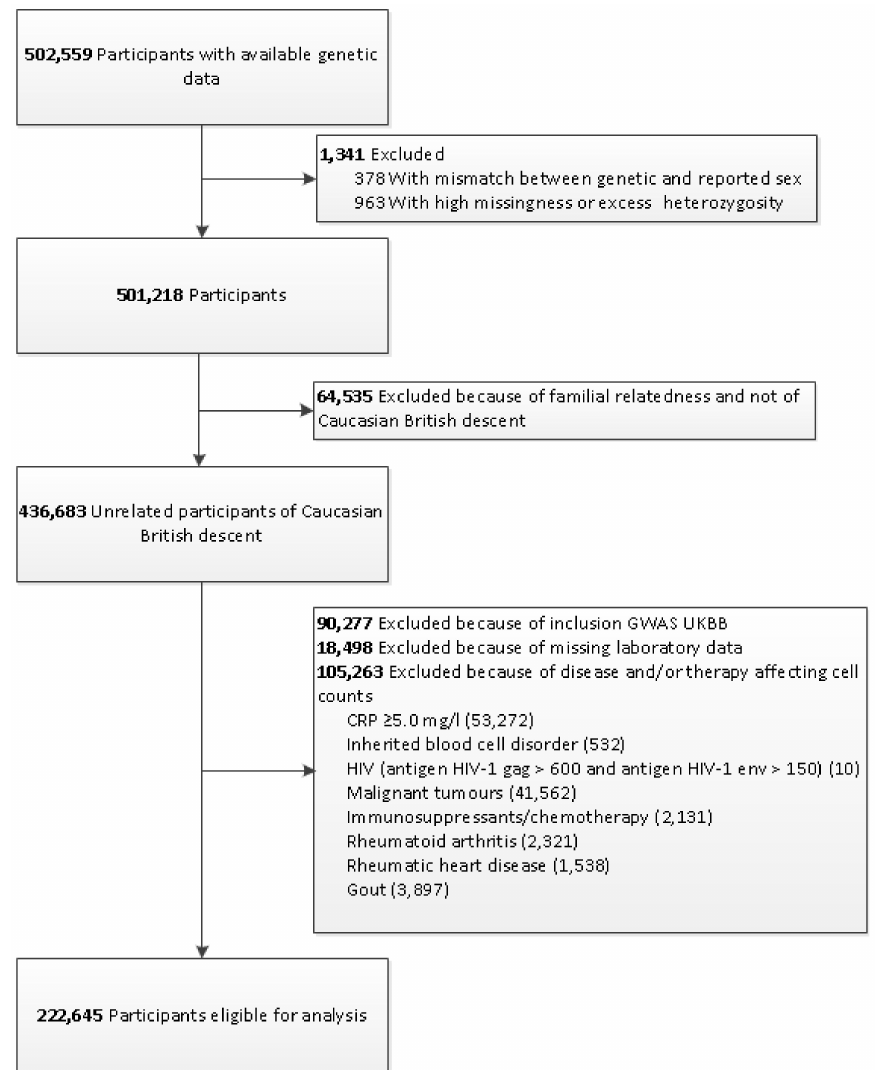
Figure 1. Flowchart for the selection of the analyzed study sample from the UK Biobank